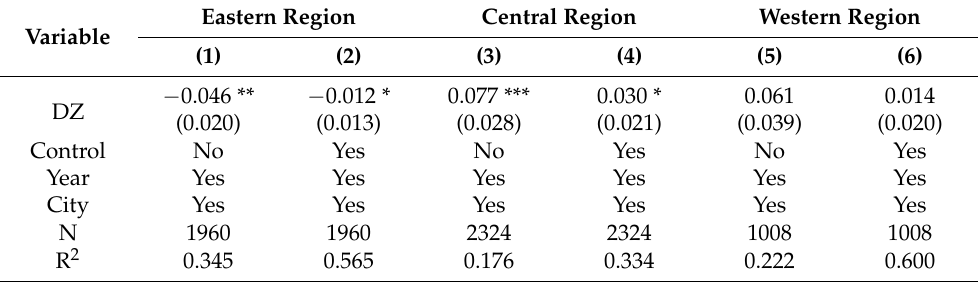
Table 7. Regional regression of the impact of DZs on economic